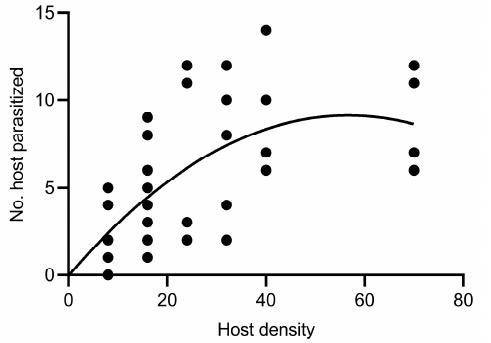
Figure 4. Functional response of Psyllaephagus sp. to increasing host density (Holling type II re- sponse, Na = 0.490 N 0 /(1 + 0.036 N 0 ); R 2 = 0.996; p <